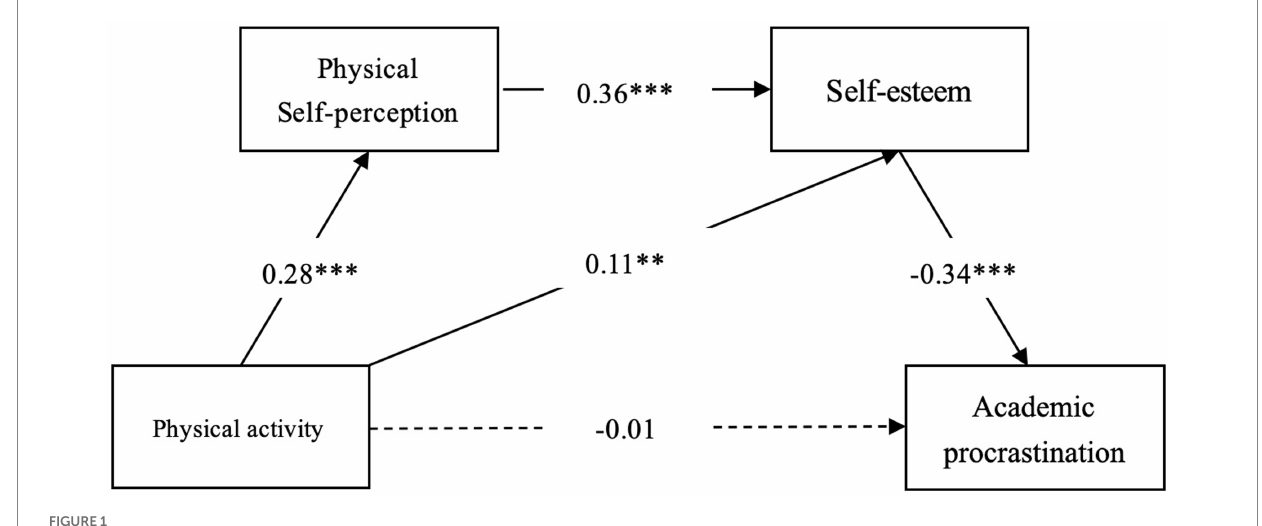
FIGURE 1 Serial mediation model of physical activity and academic procrastination through physical self-perceptions and self-esteem as serial mediators. * p < 0.05, ** p < 0.01, *** p < 0.001.